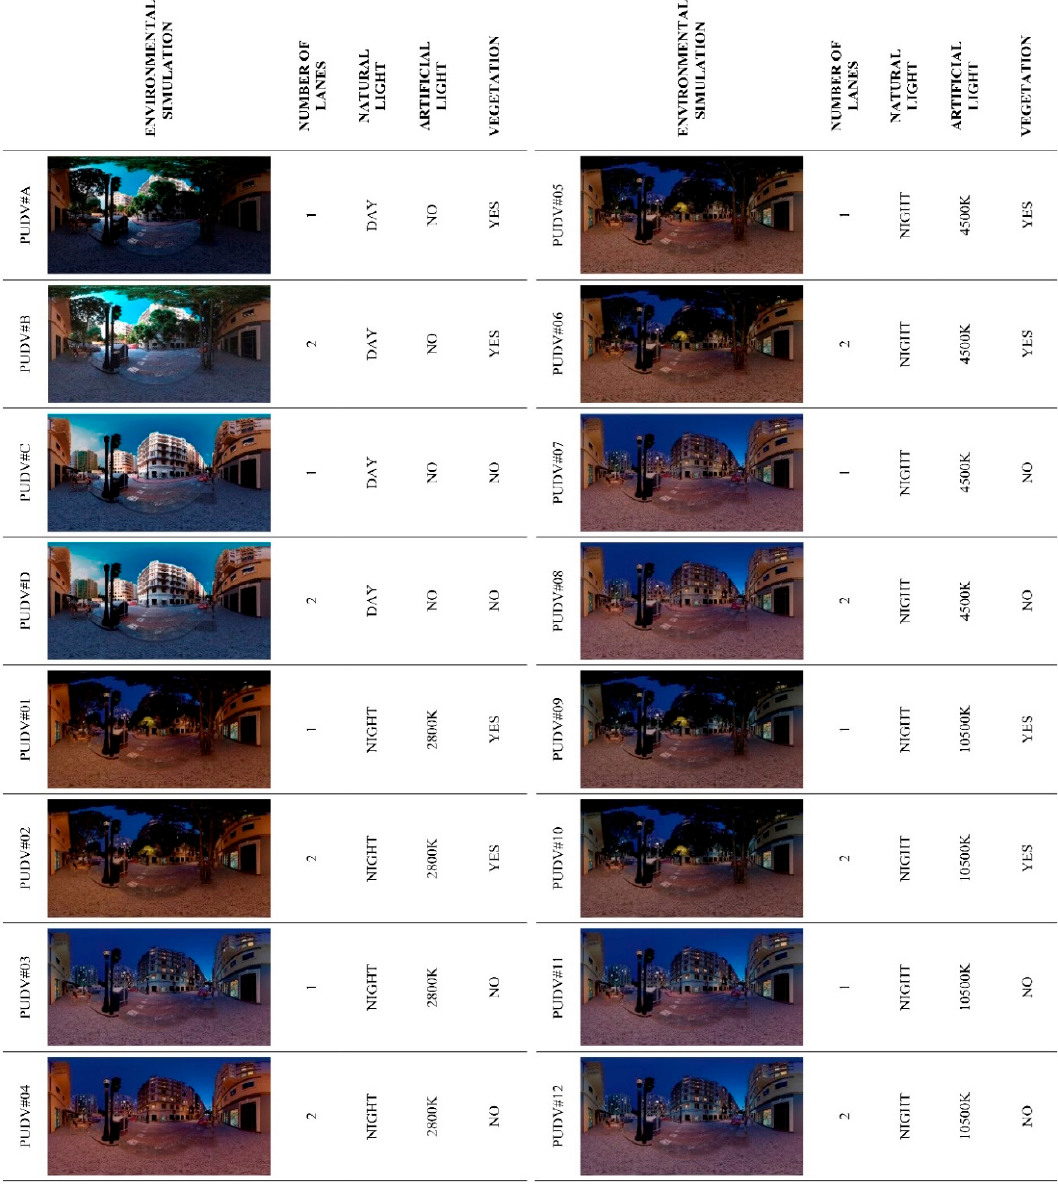
Figure 3. Configurations of the environmental simulations of the PUDVs.